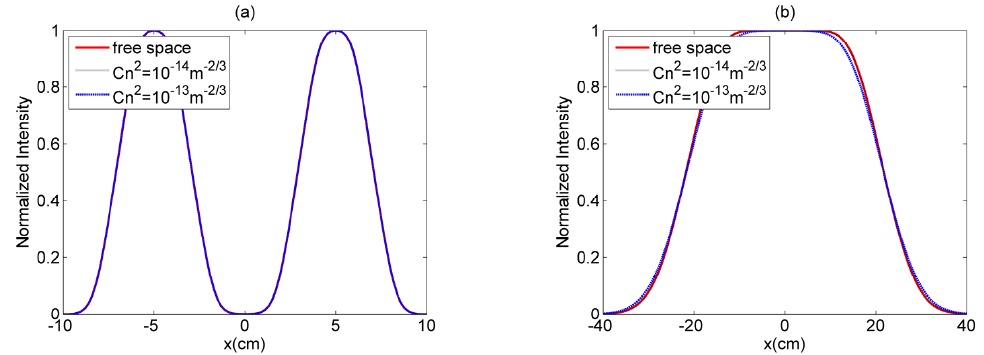
= Q in atmospheric turbulence for